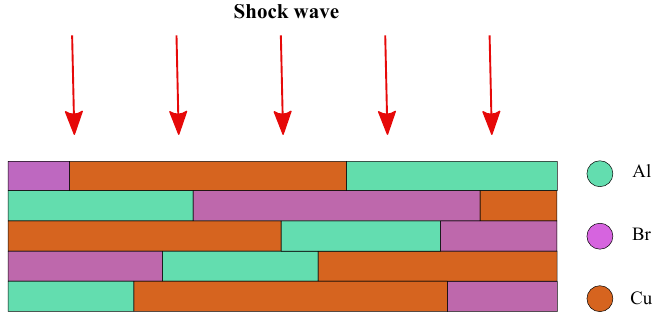
Figure 16. Schematic illustrations of nacre-like